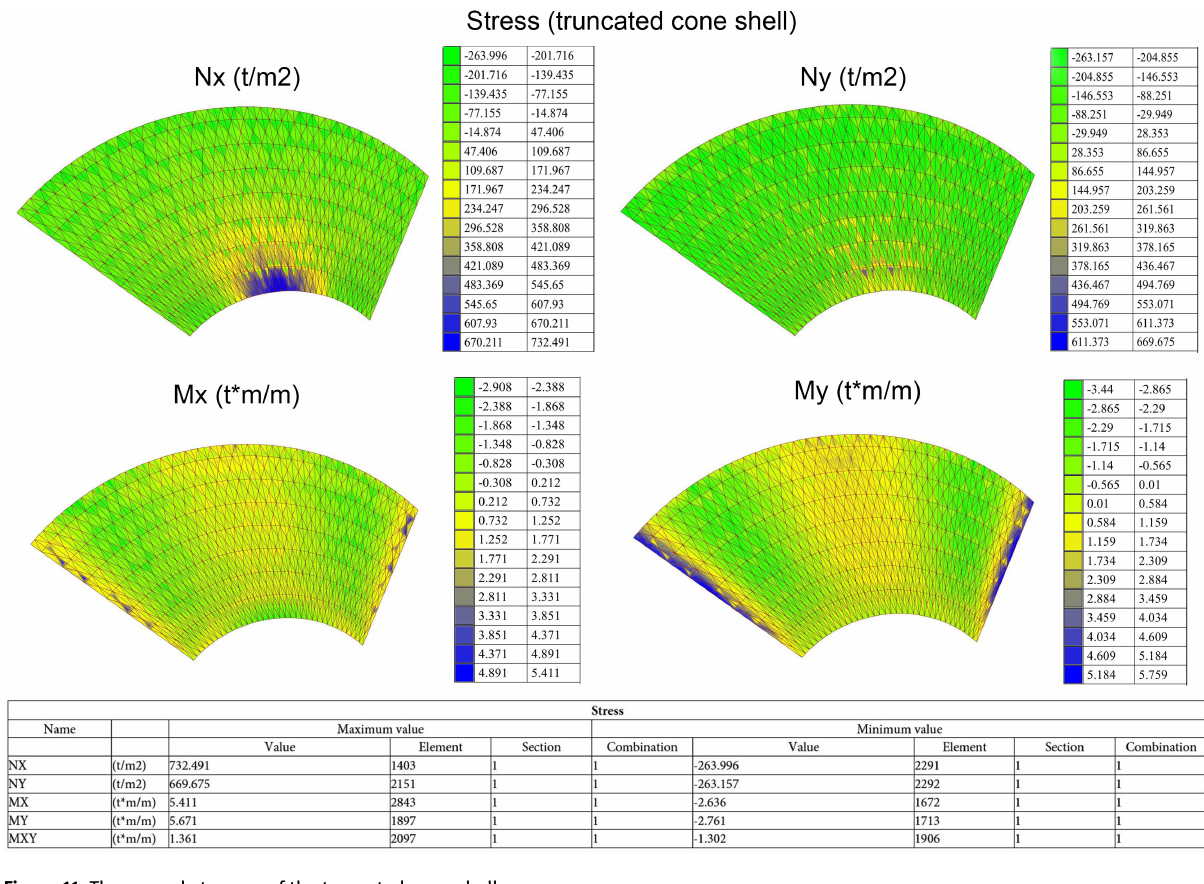
Figure 11: The normal stresses of the truncated cone shell